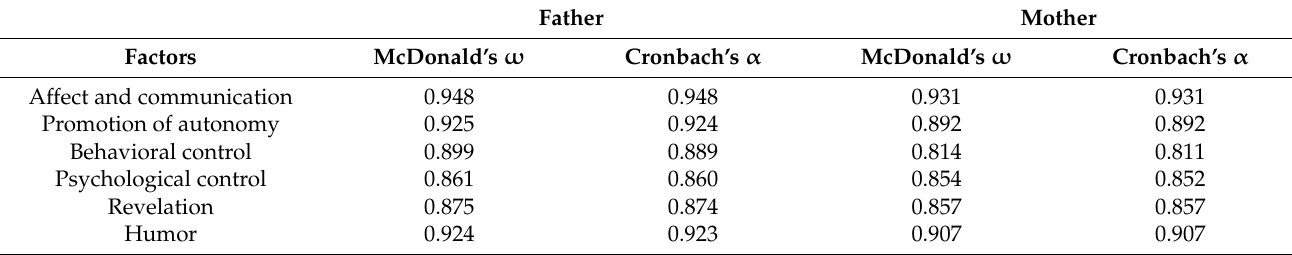
Table 3. Evidence of